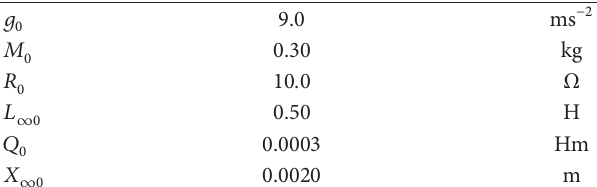
Figure 2: Membership functions of 𝑥 1 , 𝑥 2 , and 𝑥 3 . Table 1: Nominal parameters of the magnetic levitation